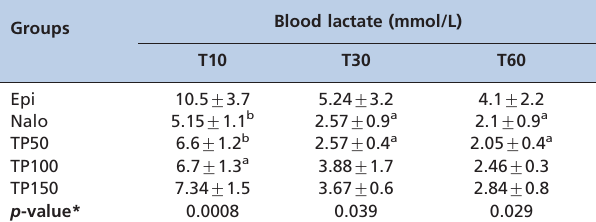
Table 6 - Bicarbonate: comparisons of the groups vs . time